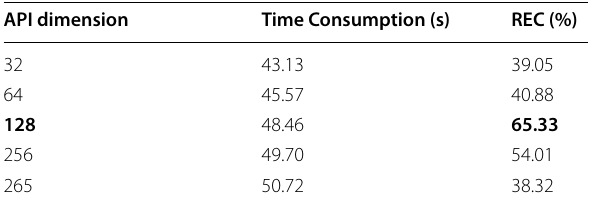
Table 11 The performance of adversarial examples in